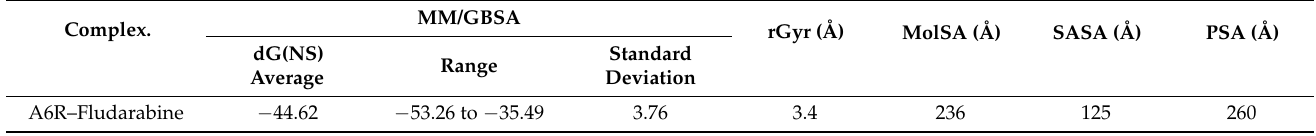
Figure 6. Time-dependent RMSF plot of protein backbones, C-alpha, and heavy atoms during the interaction with the ligand (horizontal green lines). Numbers on the x-axis indicate the number of protein residues, while the y-axis indicates the protein fluctuation in Å. ( A ). DNA-Dependent RNA Polymerase subunit (A6R) and Fludarabine, ( B ). Carbonic anhydrase (GAG-binding IMV membrane protein) (D8L) and Fludarabine, ( C ). Palmitoylated extracellular enveloped virus (EEV) membrane glycoprotein (F13L) and Fludarabine. Table 2. Binding affinities and ligand properties of the best active compounds against MPXV proteins (A6R, D8L, and